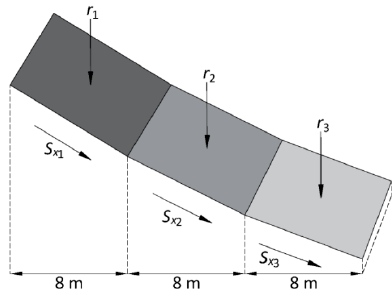
Figure 3. Domain schematization for the three planes cascade test case.